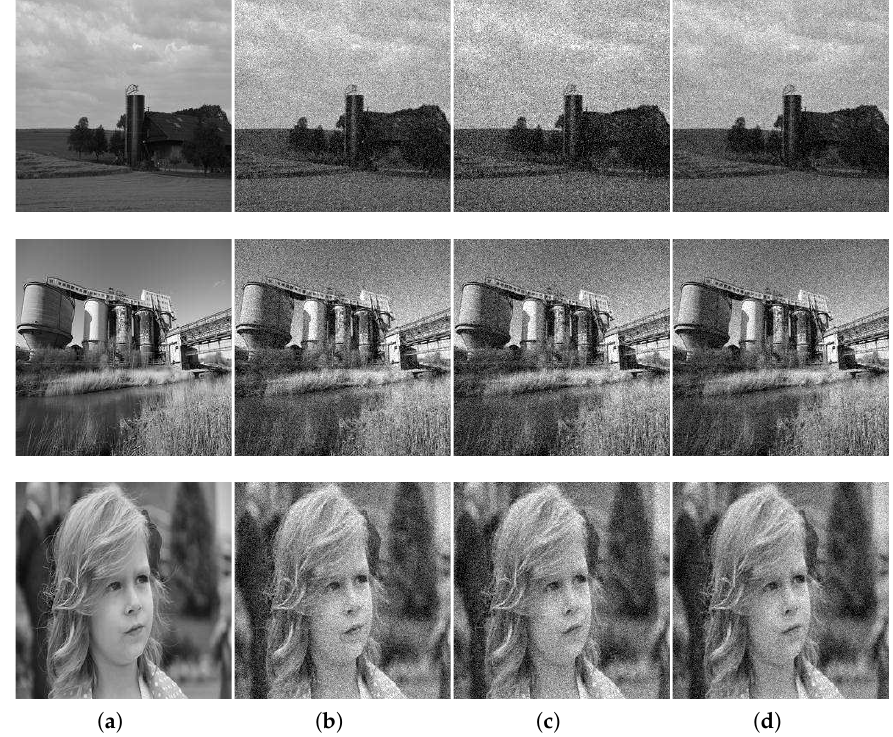
Figure 1. The original images and the simulated multi-frame degradation images. ( a ) input images of the datasets; ( b ) images degraded by the 5 × 5 PSF at SNR of 20 dB under ideal conditions; ( c ) images degraded by the 5 × 5 PSF at SNR of 25 dB under ideal conditions; ( d ) images degraded by the 5 × 5 PSF at SNR of 30 dB under ideal